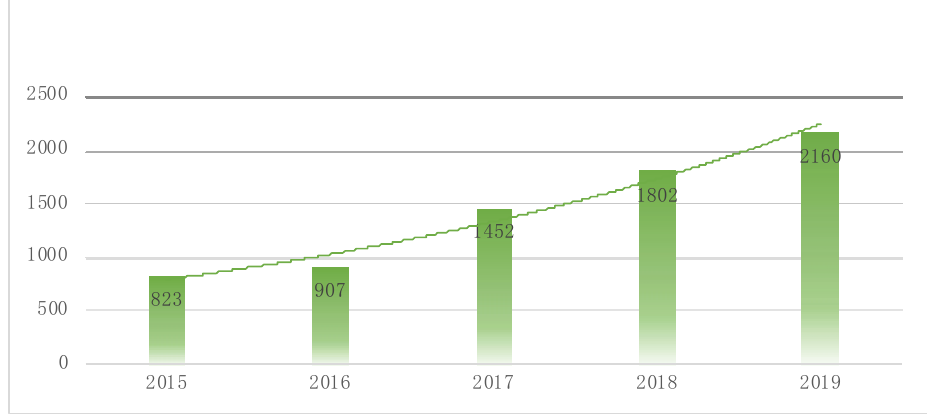
Figure 3. The number of equestrian clubs in China, data from [19].